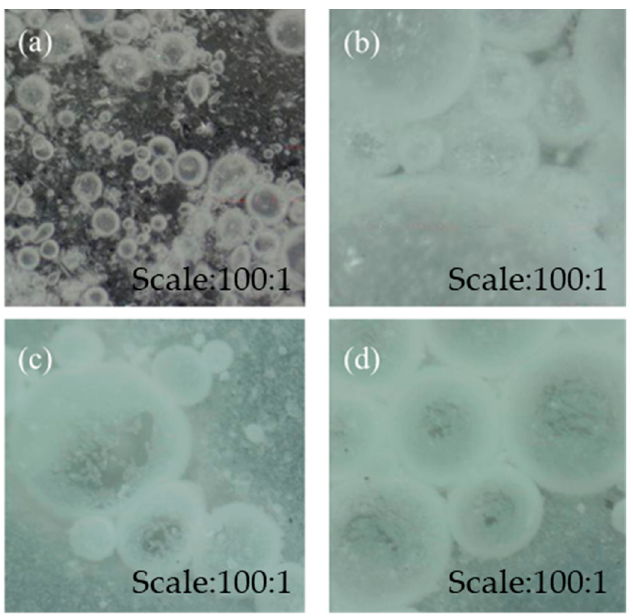
Figure 8. Foam image of ( a ) AWG-treated fluorite, ( b ) AWG + NaF-treated fluorite, ( c ) AWG-treated calcite, and ( d ) AWG + NaF-treated calcite.